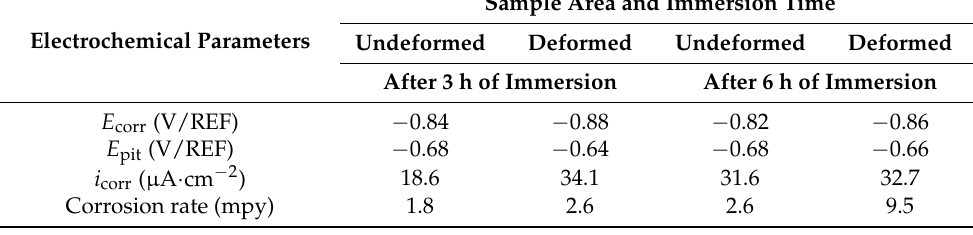
Table 3. The corrosion potential ( E corr ), pitting potential ( E pit ), corrosion current density ( i corr ), and corrosion rate calculated after 3 and 6 h of immersion in naturally-aerated 0.5 M NaCl (pH 3) for the undeformed and deformed areas of